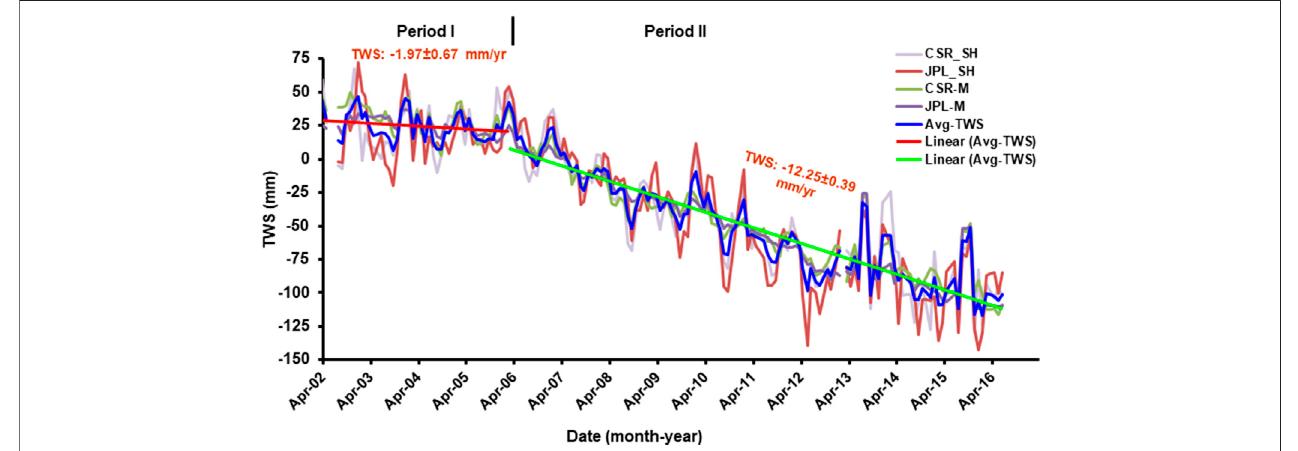
FIGURE 12 | Time series for terrestrial water storage variation from various GRACE sources over the Saq aquifer and their averaging (Avg-TWS).